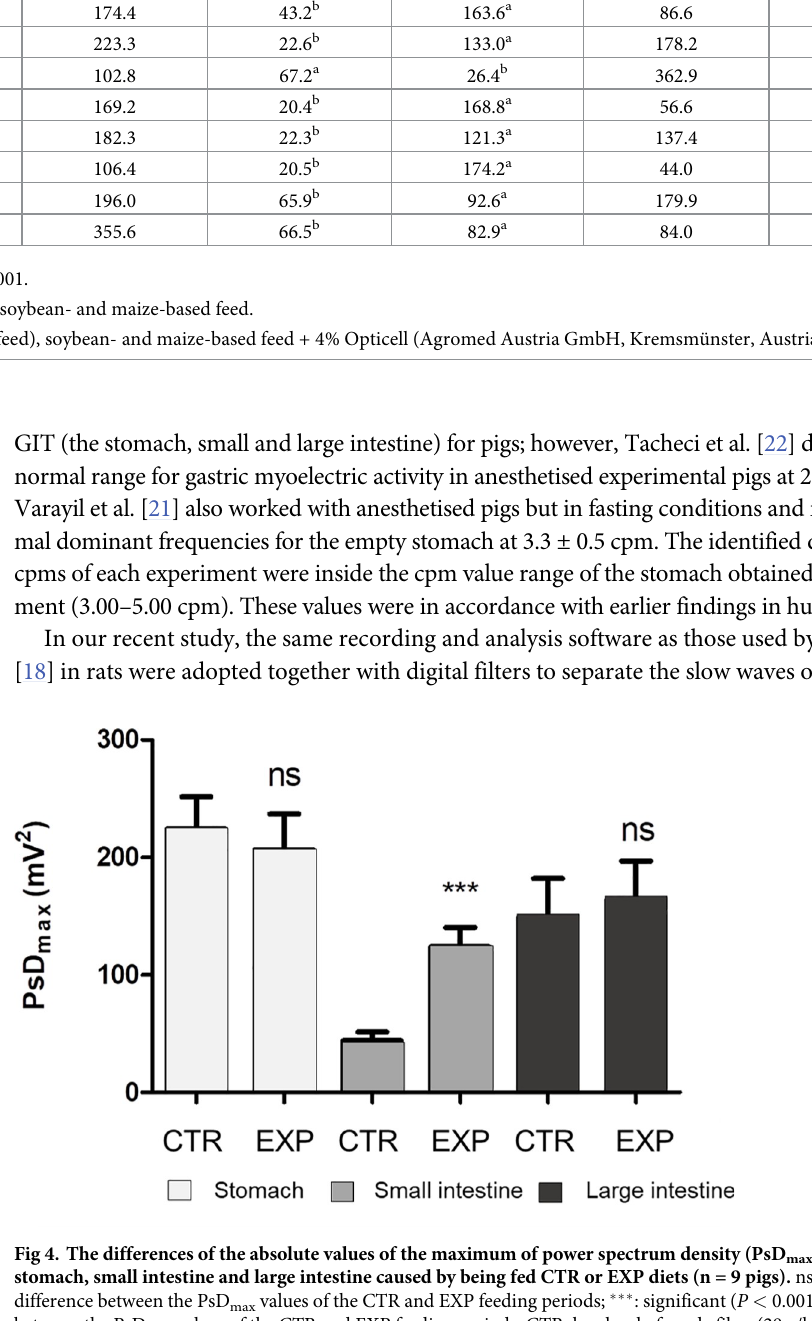
Table 2. The effect of the control and experimental diets on the absolute value of the maximum of power spectrum density (PsDmax, mV2) in the different seg- ments of the gastrointestinal tract (n = 9 pigs). Absolute value for PsD max (mV 2 ) Stomach (3–5 cpm) Small intestine (20–25 cpm) Large intestine (1–3 cpm) Animal No.